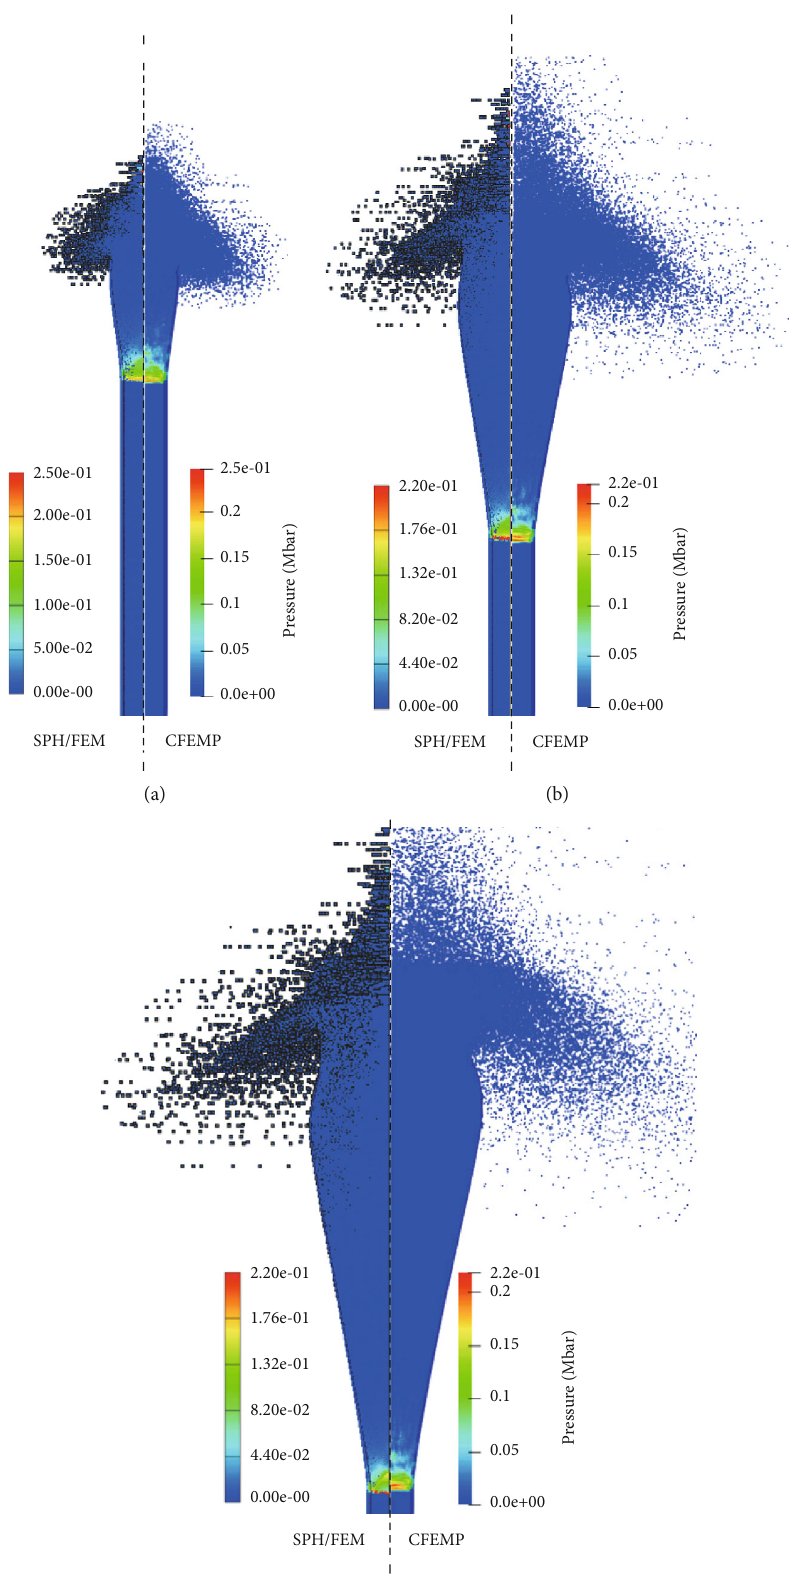
Figure 7: Comparisons of pressure contour by CFEMP and SPH/FEM schemes for cylinder test in air medium: (a) t = 15 μ s, (b) t = 30 μ s, and (c) t = 45 μ